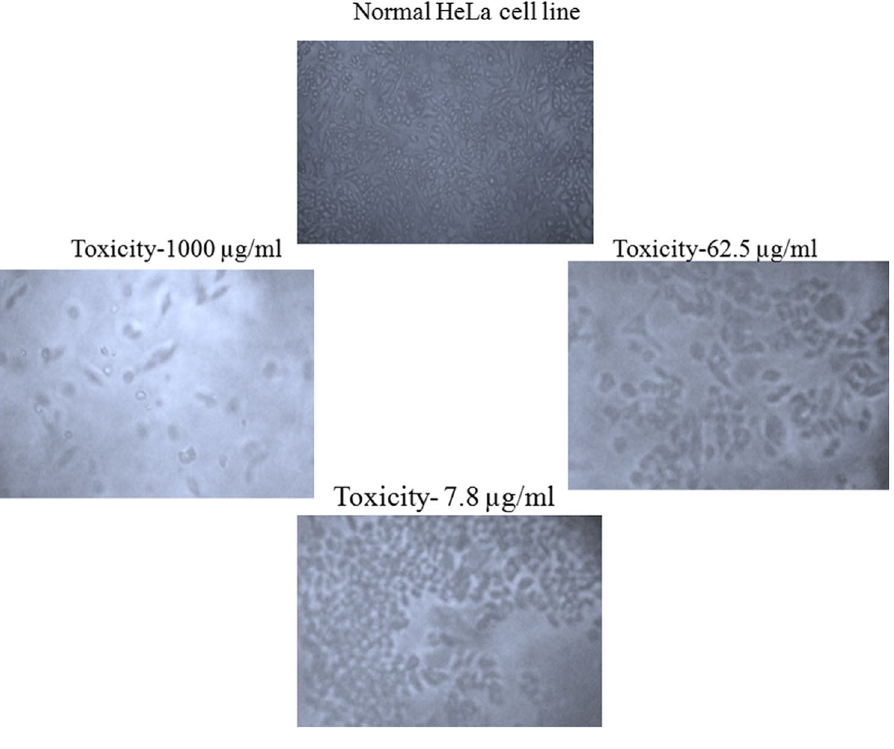
Figure 7. Cytotoxic activity of L. siceraria mediated ZnO NPs on HeLa cell line.